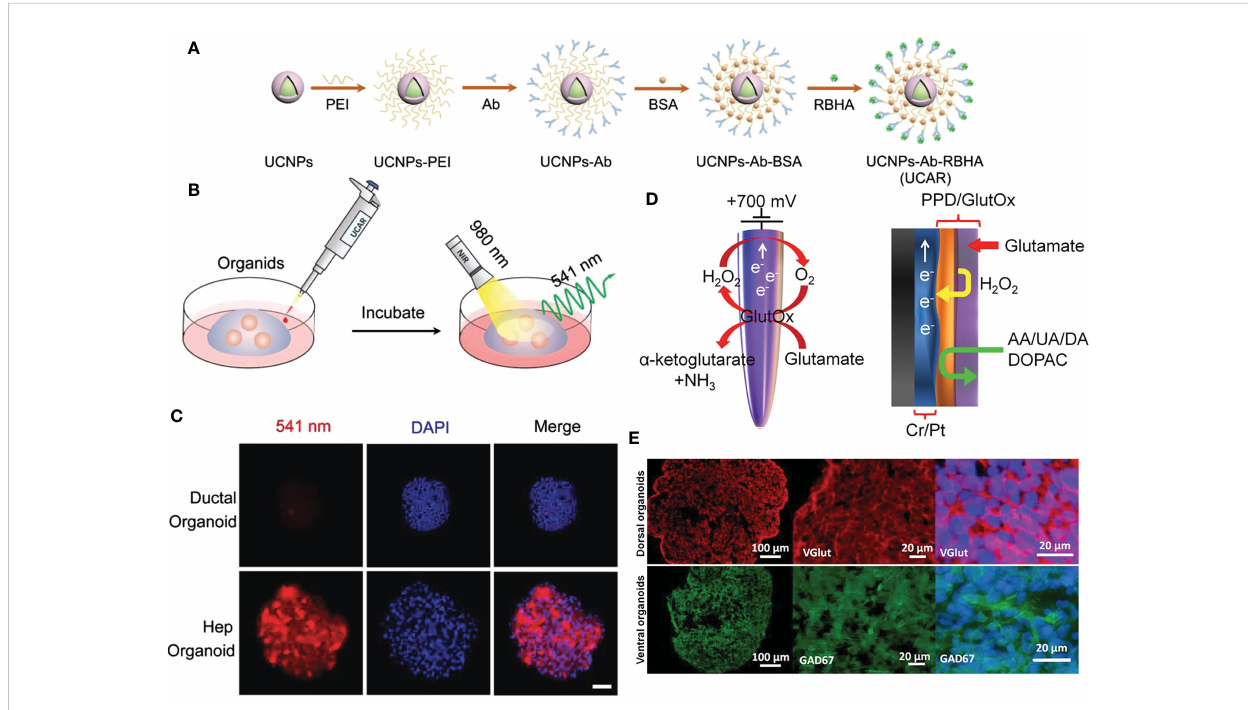
FIGURE 4 NMs for cell imaging and biosensor in organoids. (A) The schematic diagram of UCAR synthesis process from NaYF4:Yb3+/Er3+@NaYF4 (UCNPs). (B) The schematic illustration of albumin imaging in organoids using UCAR. (C) Ductal organoids and hepatocyte organoids were incubated with UCAR (red) for 3 h, followed by fi xation and DAPI (blue) staining, and imaged by two-photon microscope under 980 nm excitation (bar: 50 m m). (D) Schematic representation of enzymatic reaction that allows detection of glutamate at the microelectrode, and graphical view showing PPD layer acting as a diffusion barrier to biomolecule species. H 2 O 2 can reach the electrode while larger molecules are rejected. (E) Immunostaining images of hESC ‐ derived cortical dorsal forebrain organoids with strong expression of the glutamatergic marker, vGlut (red) and ventral forebrain organoids with expression of GABAergic neuronal marker, GAD67 (green). UCAR: upconversion nanoparticles, antibody, and rose bengal hexanoic acid; PPD, polypropylene diene monomer; hESC, human embryonic stem cell; GAD67, glutamate decarboxylase 67 kDa isoform. Adapted with permission from (69), copyright 2022, Wiley-VCH GmbH and (70), copyright 2018, Multidisciplinary Digital Publishing